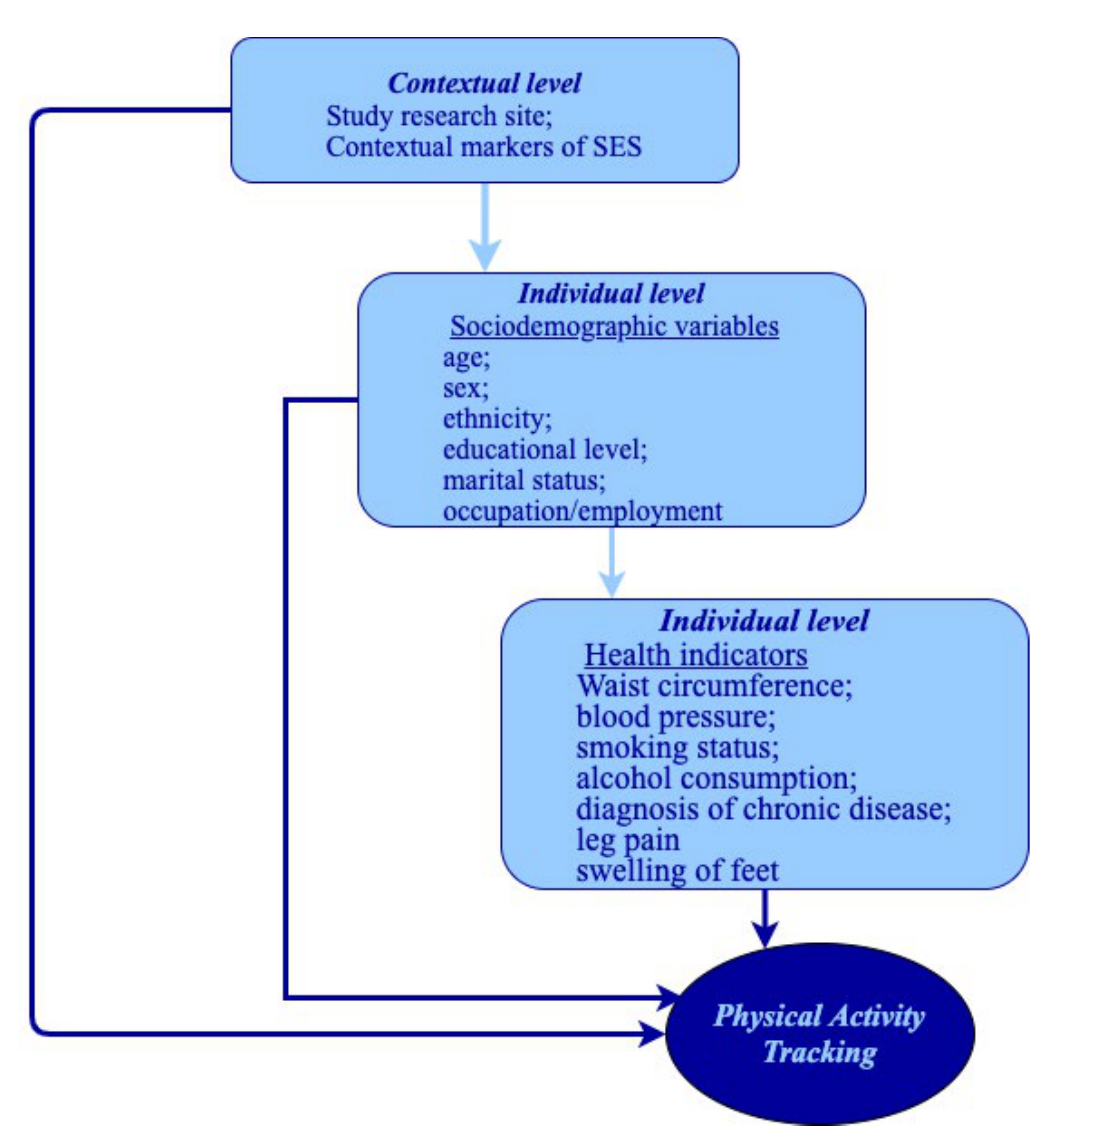
Figure 1. Conceptual multi-level framework of exposure effects on physical activity patterns.